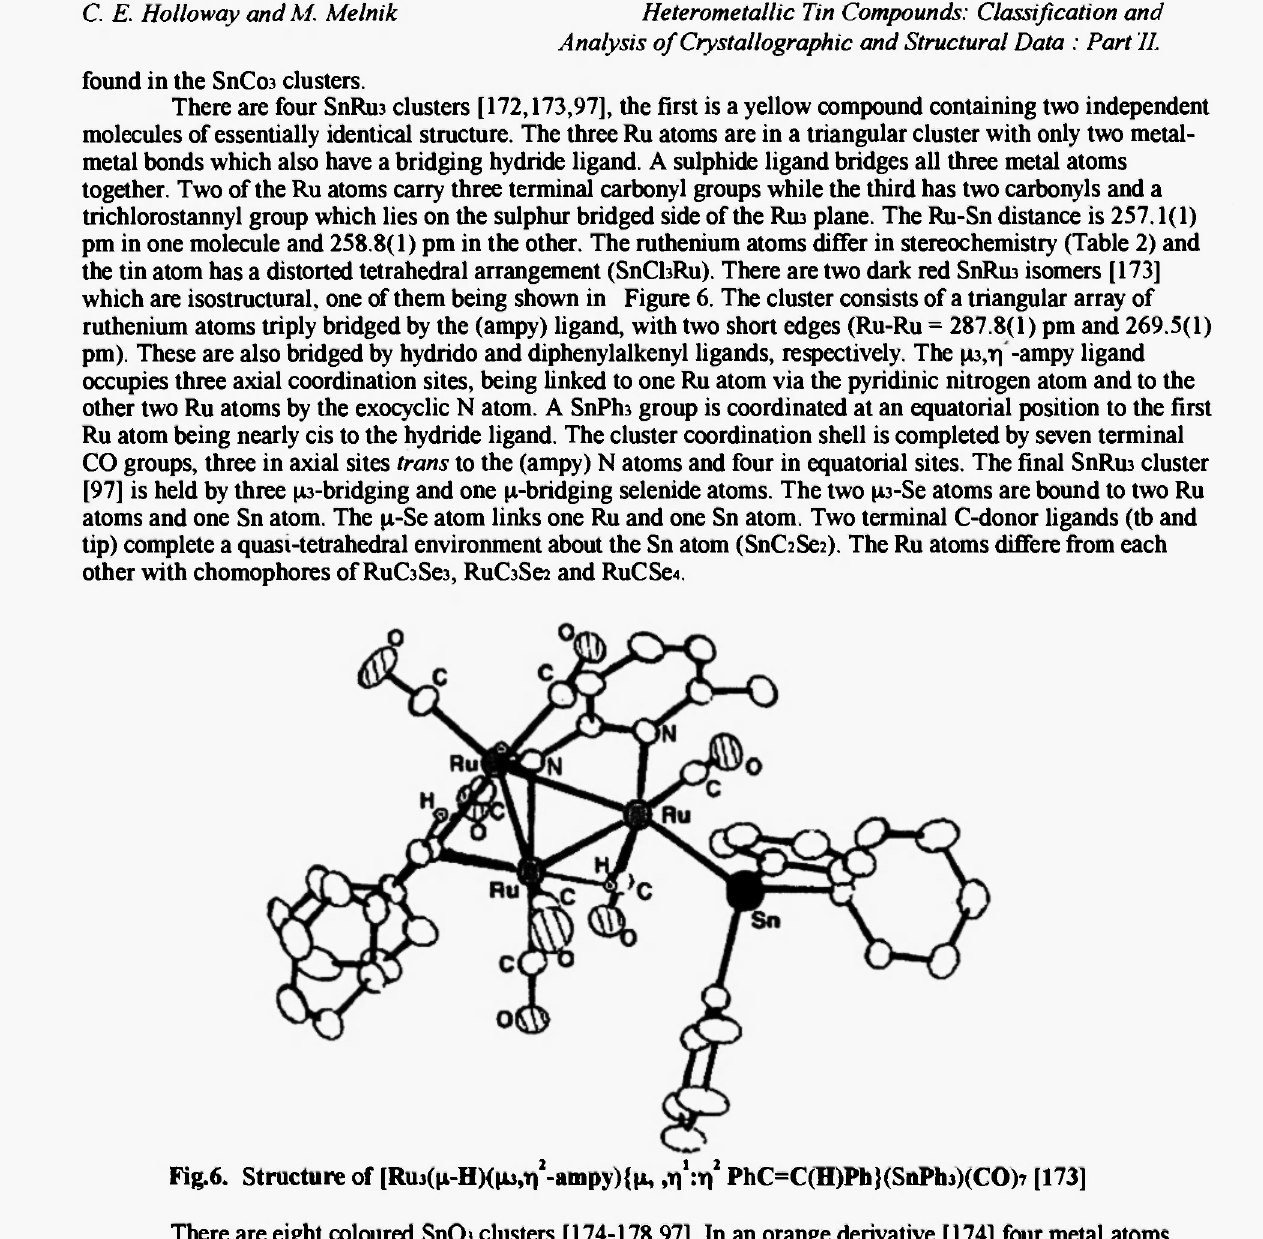
Fig.6. Structure of [Ruj^-HX|A3,Ti 2 -ampy){m ,η':η 2 PhC=C(H)Ph}(SnPhi)(CO)7